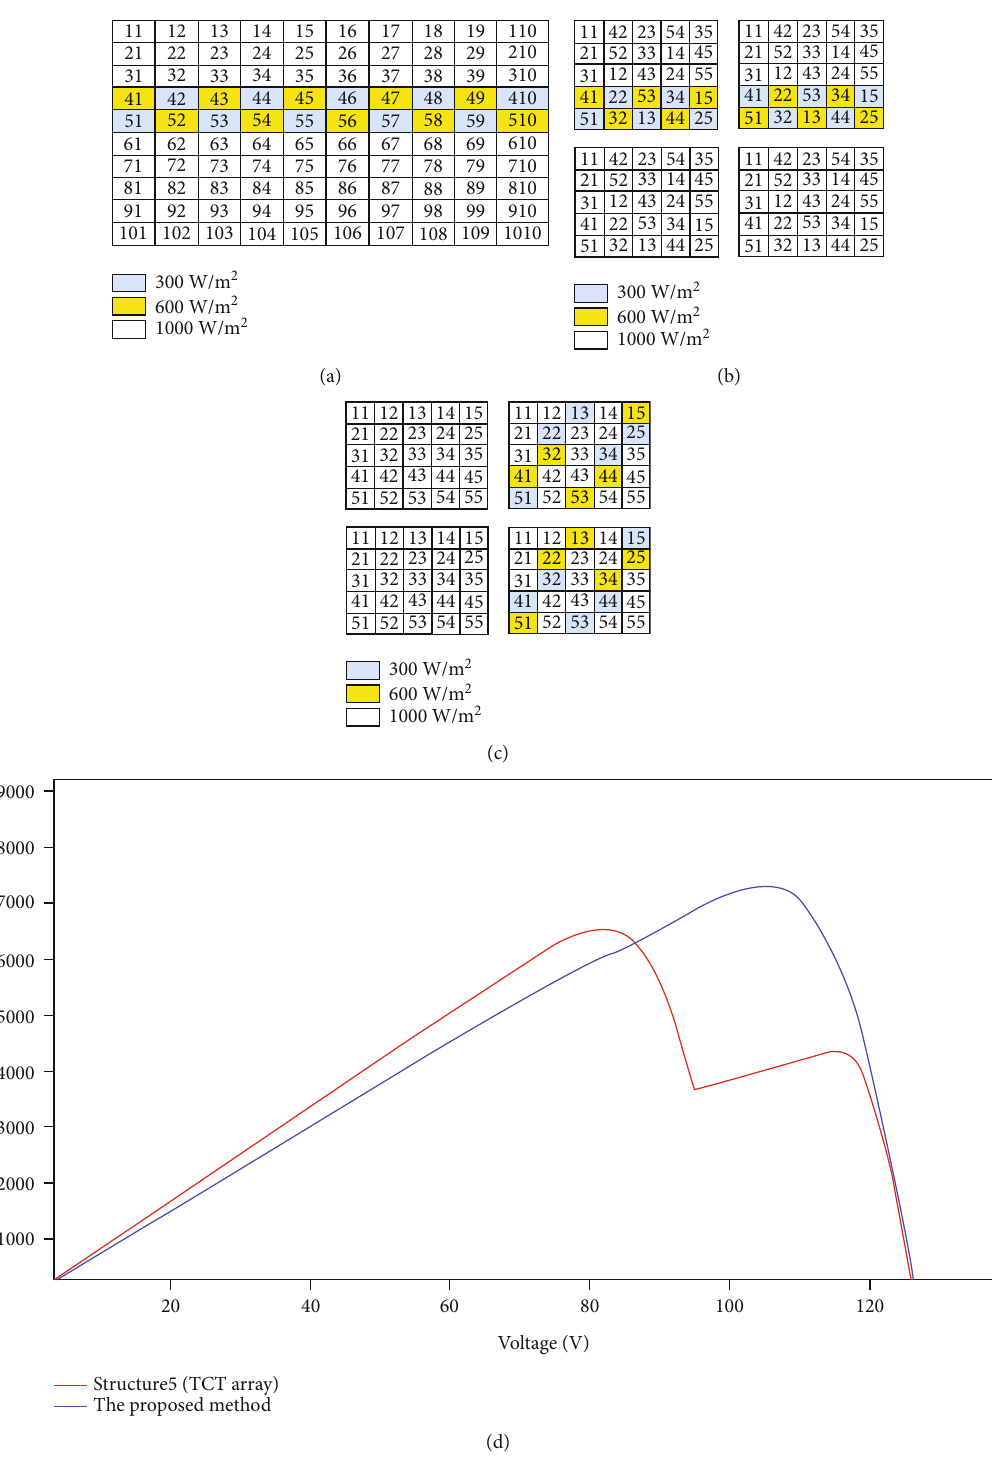
Figure 11: Second shading pattern. (a) TCT array. (b) The proposed method before recon fi guration. (c) The proposed method after recon fi guration. (d) The PV array characteristics for the TCT array and the proposed